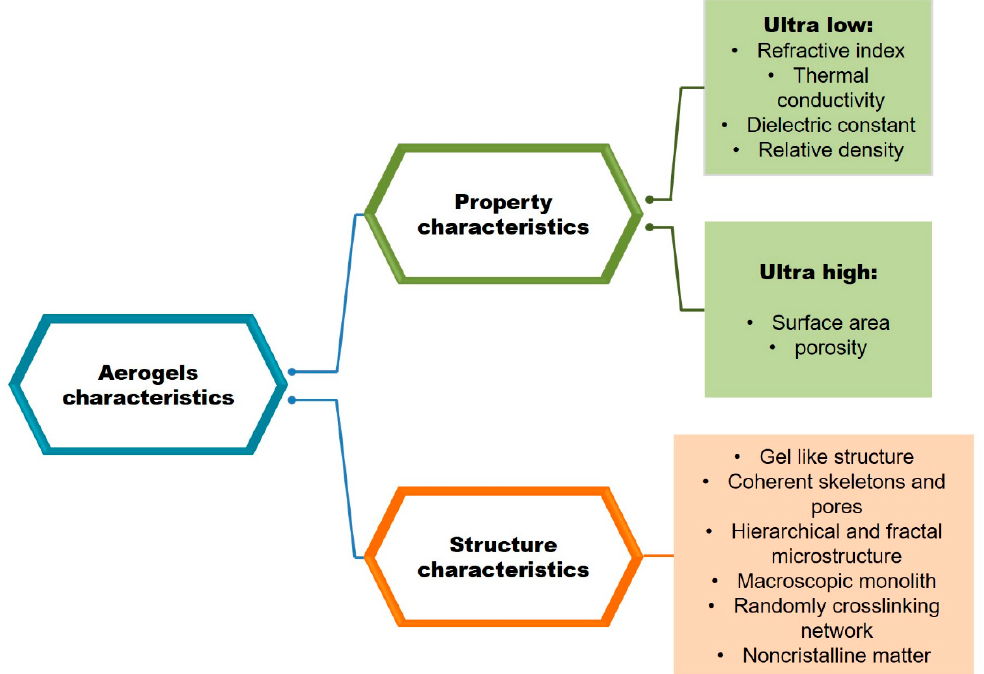
Figure 1. The main characteristics of aerogel type materials (adapted from Reference [24]).